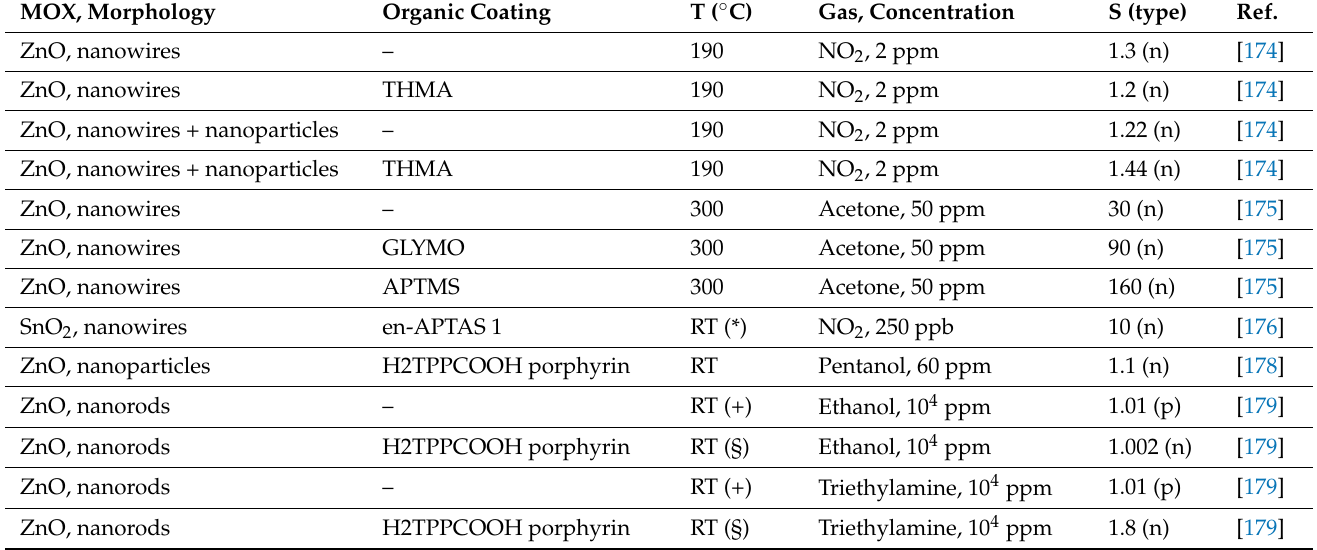
Table 7. Chemiresistors based on metal oxide (MOX) nanostructures functionalized with organic molecules. The response intensity S is calculated as S = R gas /R air for NO 2 and as S = R air /R gas